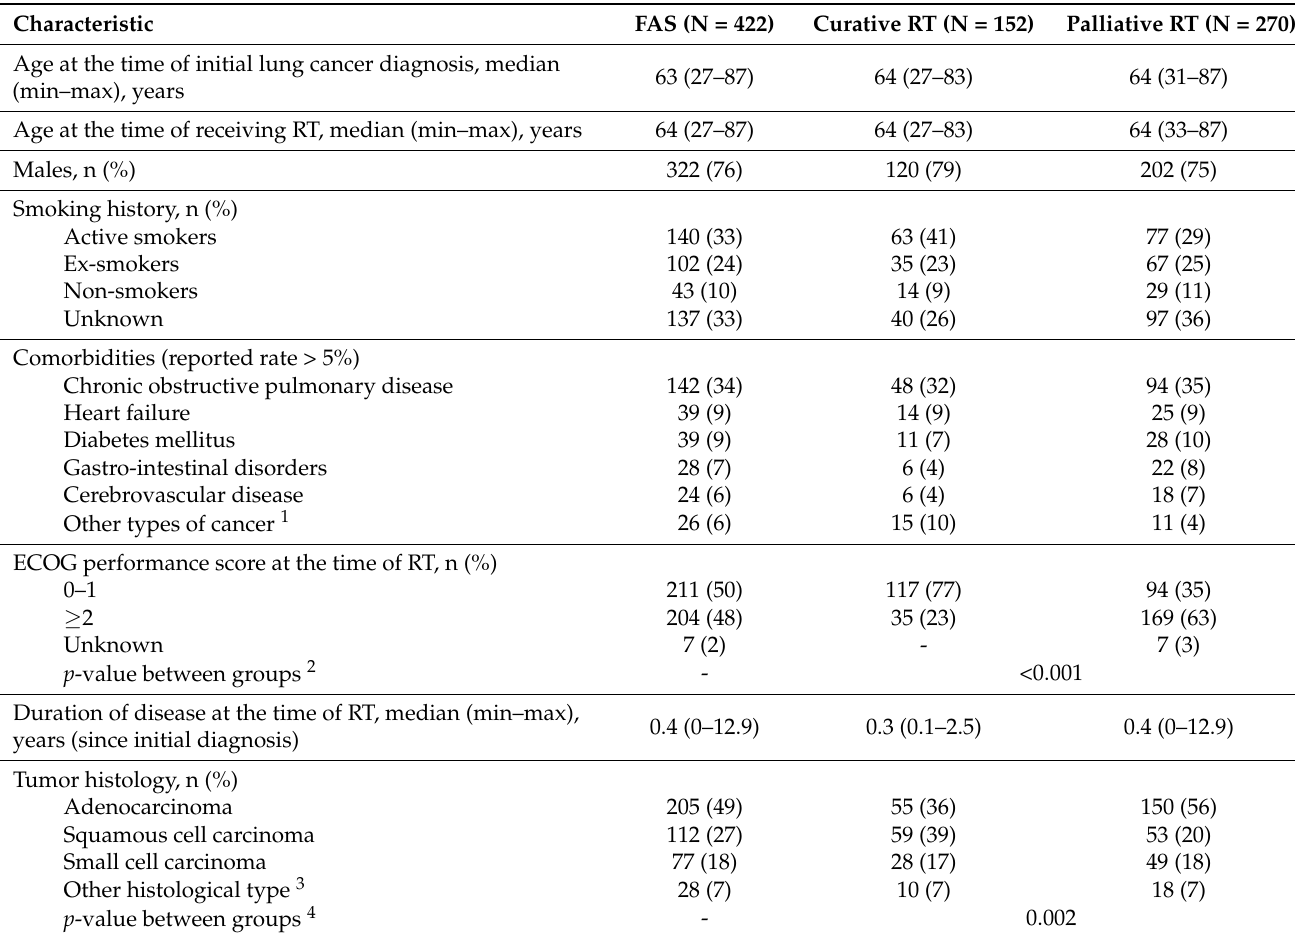
Table 2. Patient characteristics in the overall set, curative RT and palliative RT